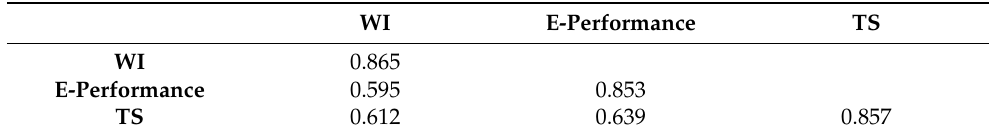
Table 4. Discriminant validity.